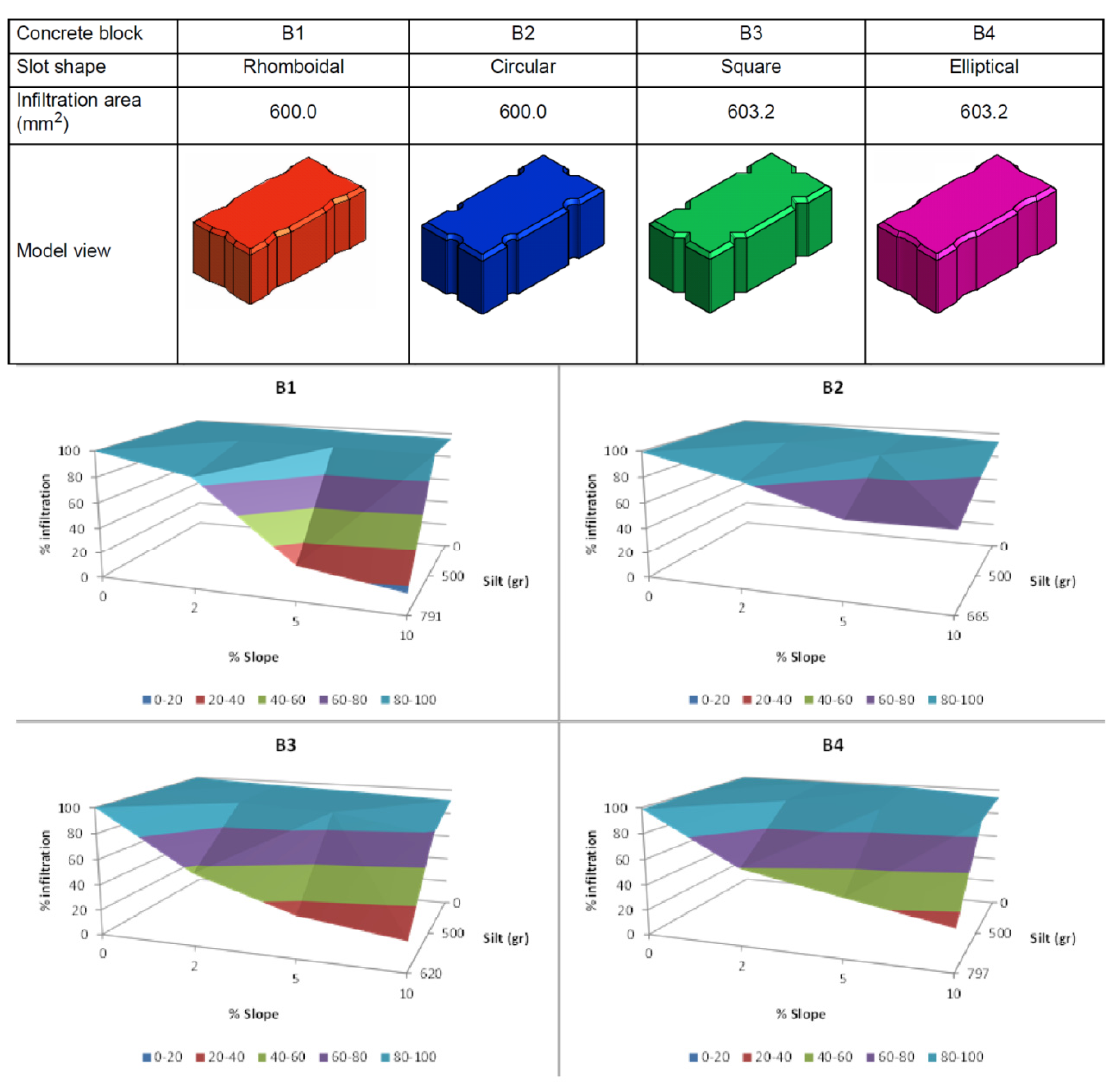
Figure 2. Permeability results of different ICBP surfaces obtained with CFI, (self-made from the results obtained by Castro et al.